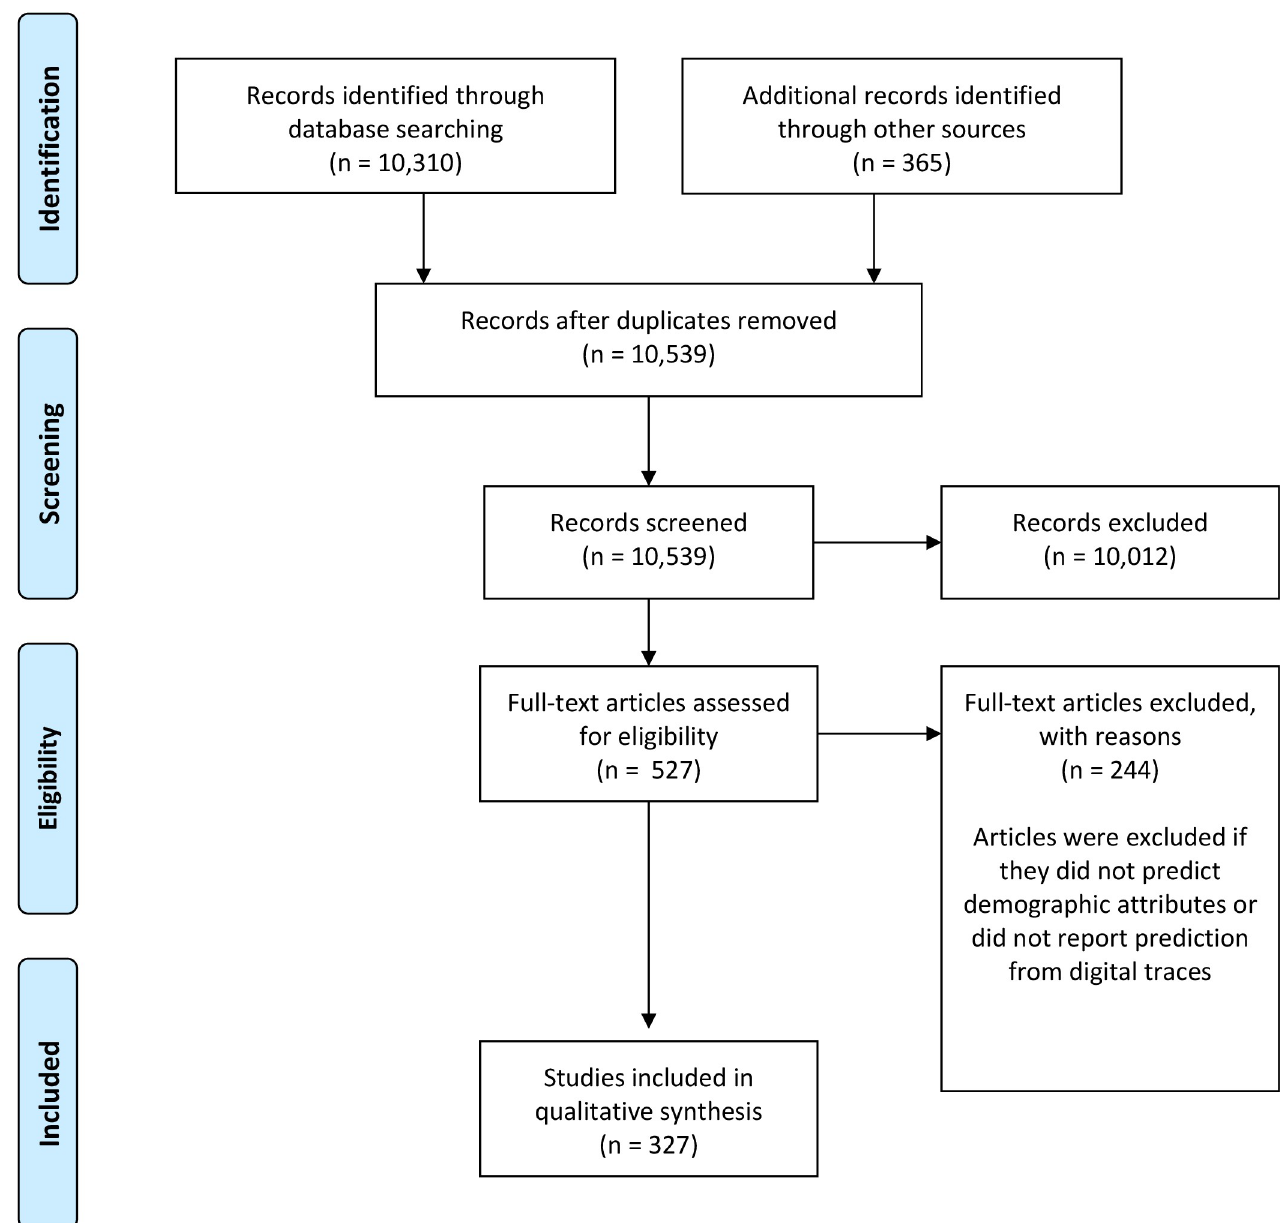
Fig 1. PRISMA Flowchart summarising study retrieval and